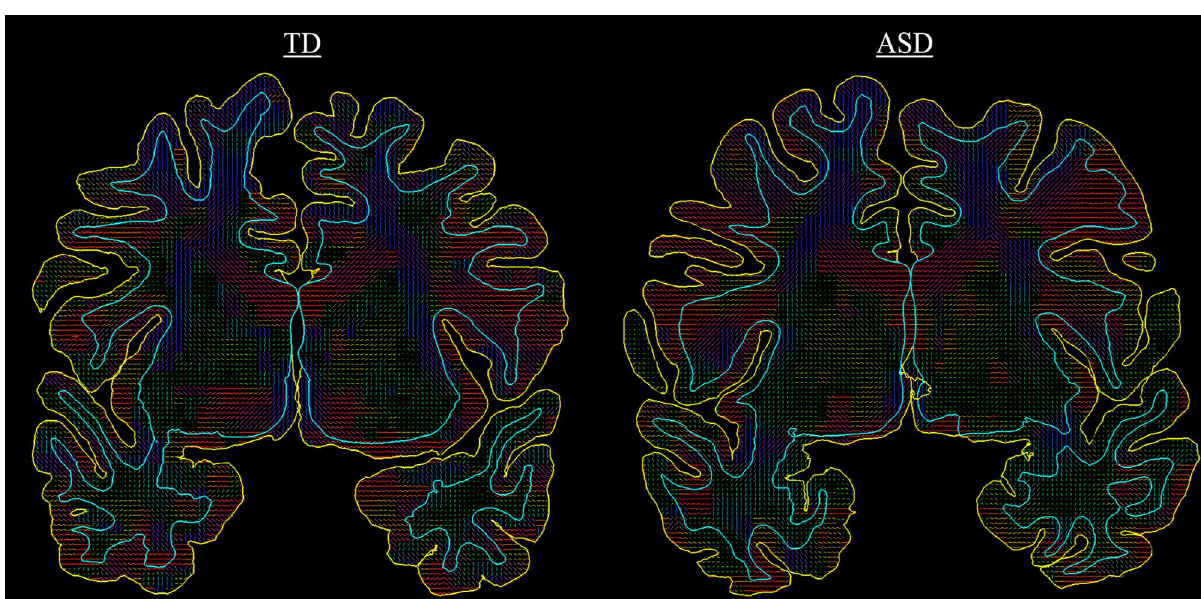
Figure 5. Example of directional diffusion tensors in a mid-brain slice of a typically developing versus autism spectrum disorder participant. Red lines indicate left to right diffusion, blue lines indicate up to down diffusion, and green lines indicate front to back diffusion in the brain. The primary direction of GM diffusion in both brains is largely seen as perpendicular to the cortical mantle (AK), and thus the secondary (radial) diffusion direction is parallel to the cortical mantle